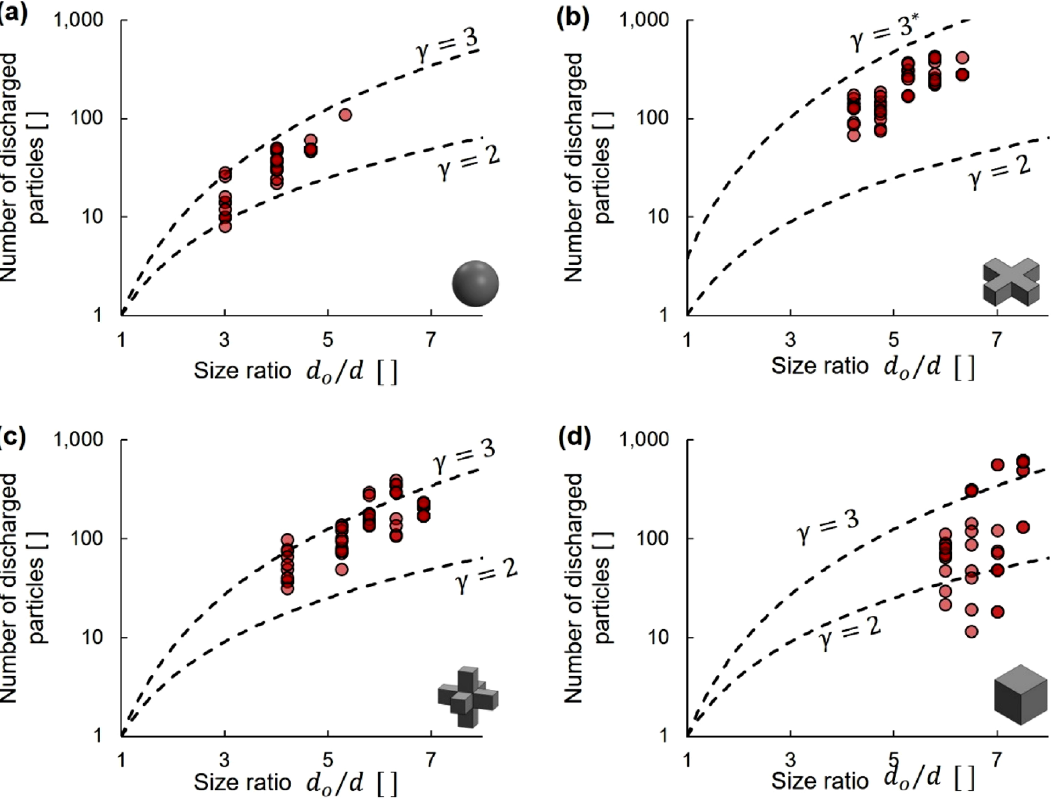
Figure 4. Dry granular flow: number of particles discharged before clogging as a function of the size ratio d o / d. Granular shapes: ( a ) spheres, ( b ) 2D cross, ( c ) 3D cross and ( d ) cubes. Datapoints: 134 independent experimental realizations. Lines: power function (Eq. 3). The γ-exponents selected to capture the lower (γ = 2) and upper (γ = 3) bounds. *The upper bound for the 2D cross data takes into consideration particle flatness (Eq.